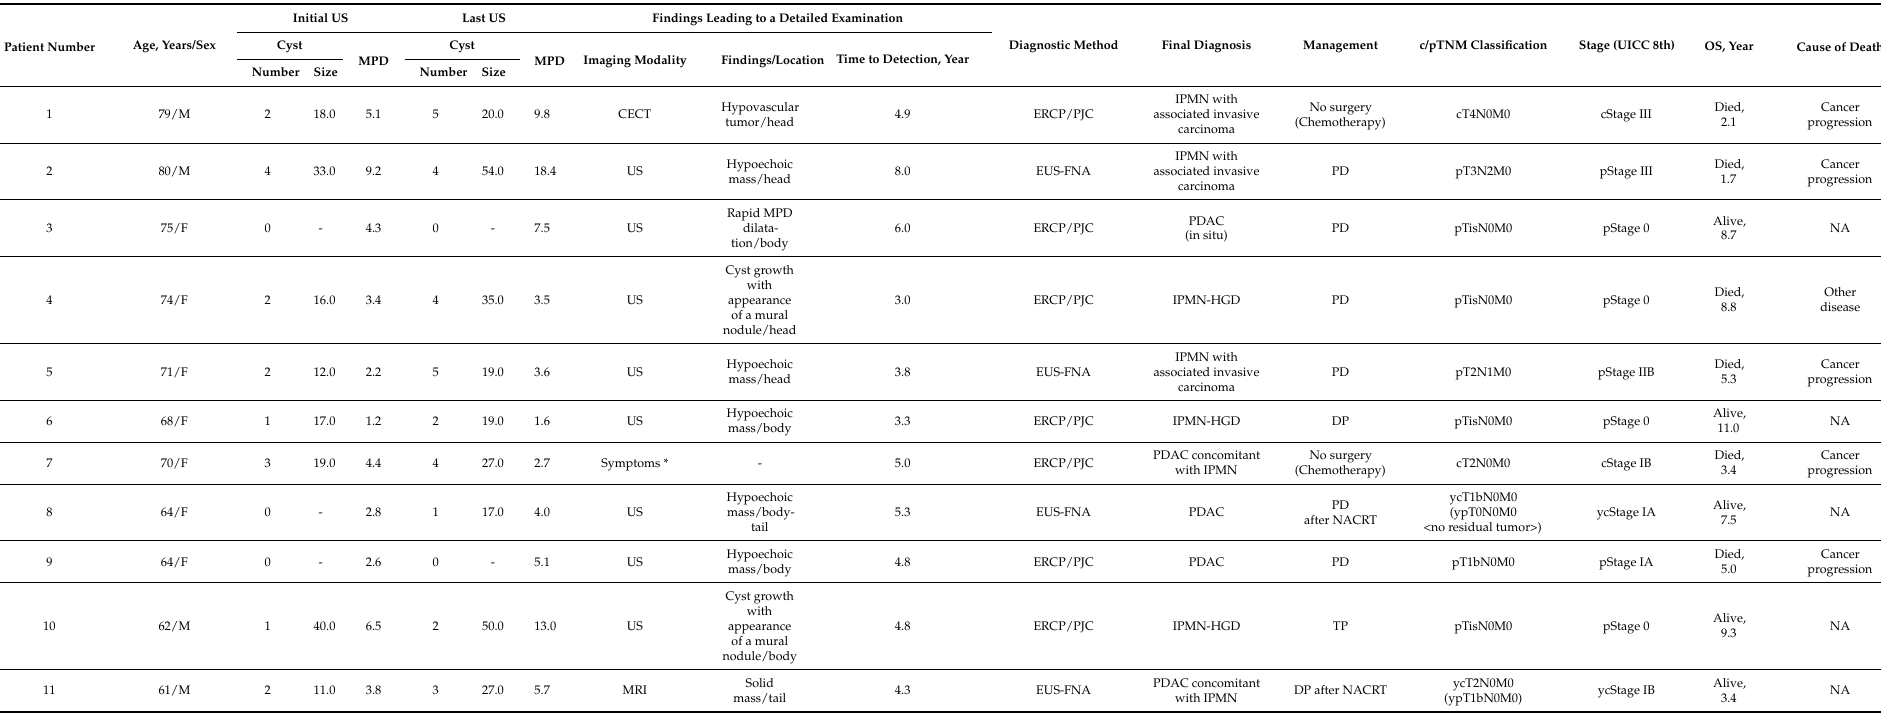
Table 2. Characteristics of patients with neoplastic progression detected during surveillance with special pancreatic